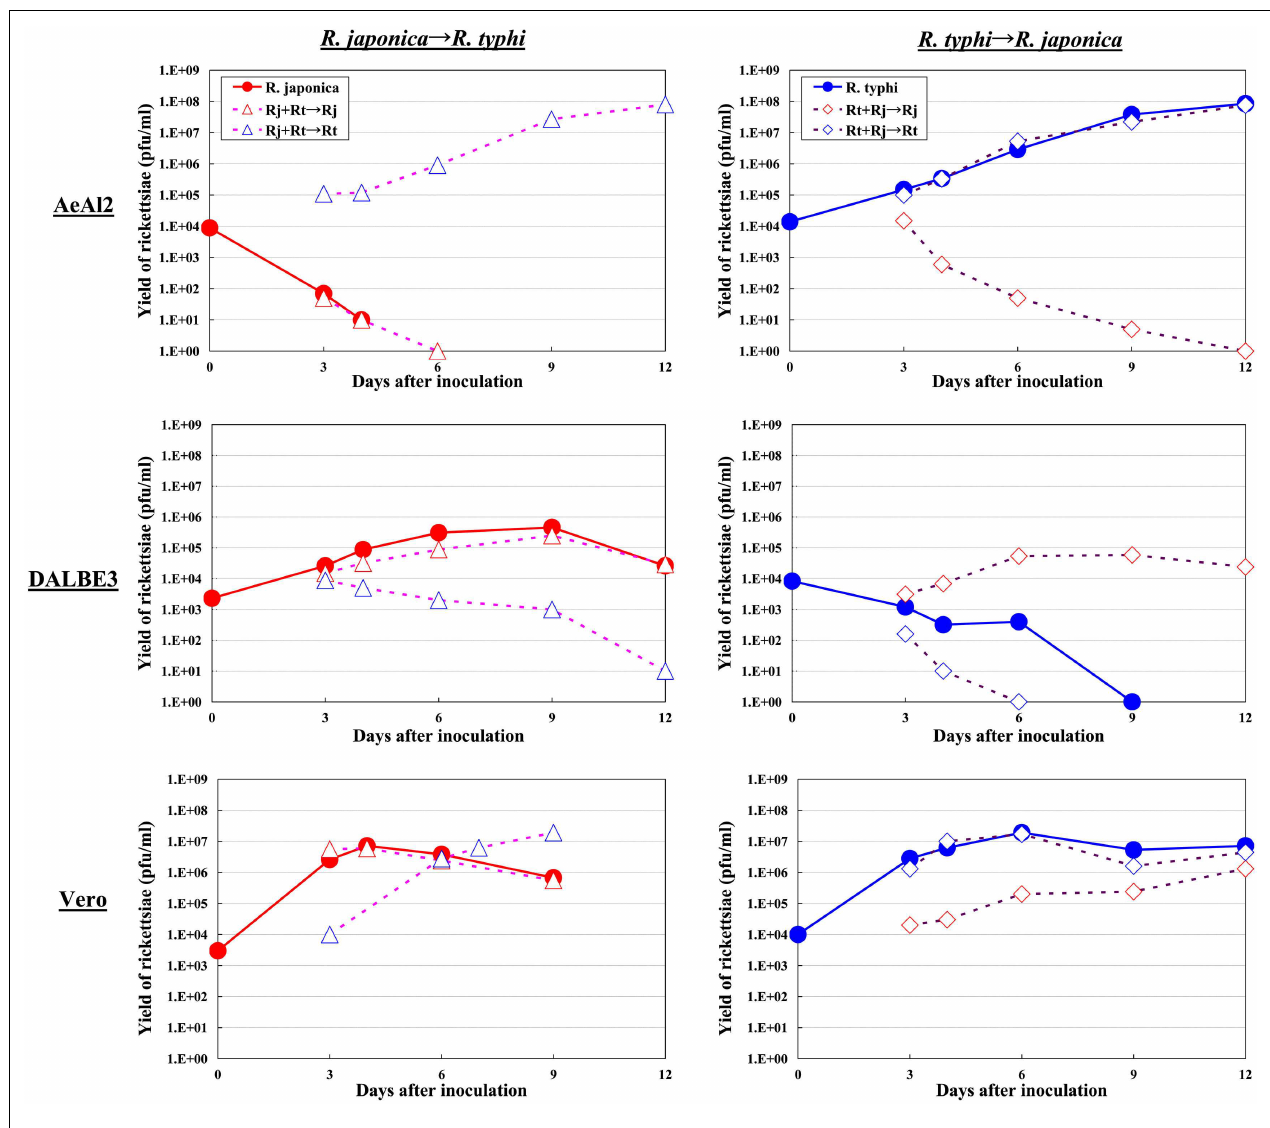
infected cultures were superinfected withTG or SFGR, respectively, on day three of infection, and the growth of each Rickettsia species was